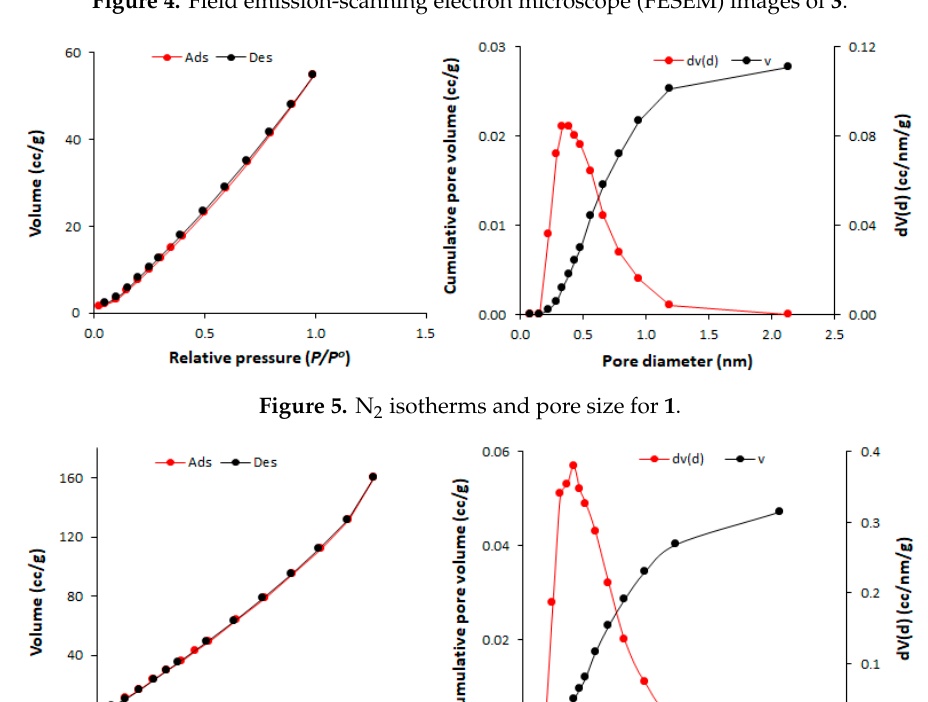
Figure 4 . Field emission-scanning electron microscope (FESEM) images of 3 . Figure 4. Field emission-scanning electron microscope (FESEM) images of 3 .